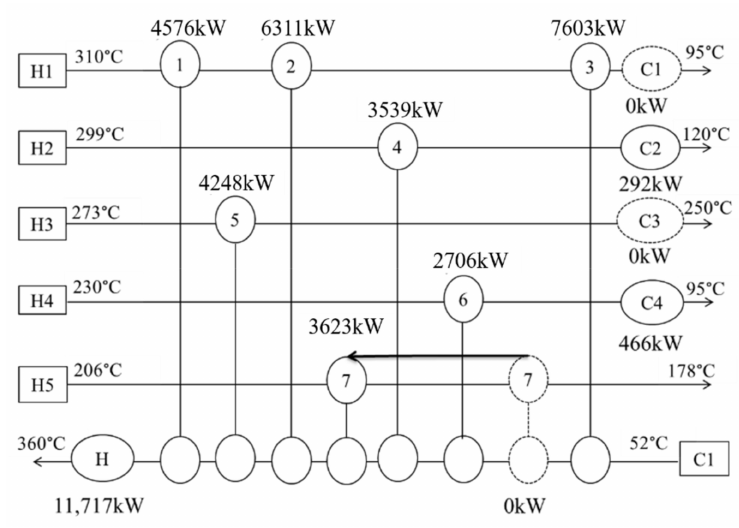
Figure 16. The best modification for first step retrofit of